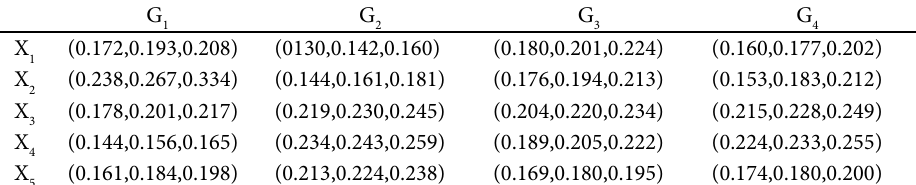
Table 10. Decision matrix R  (FPWA)